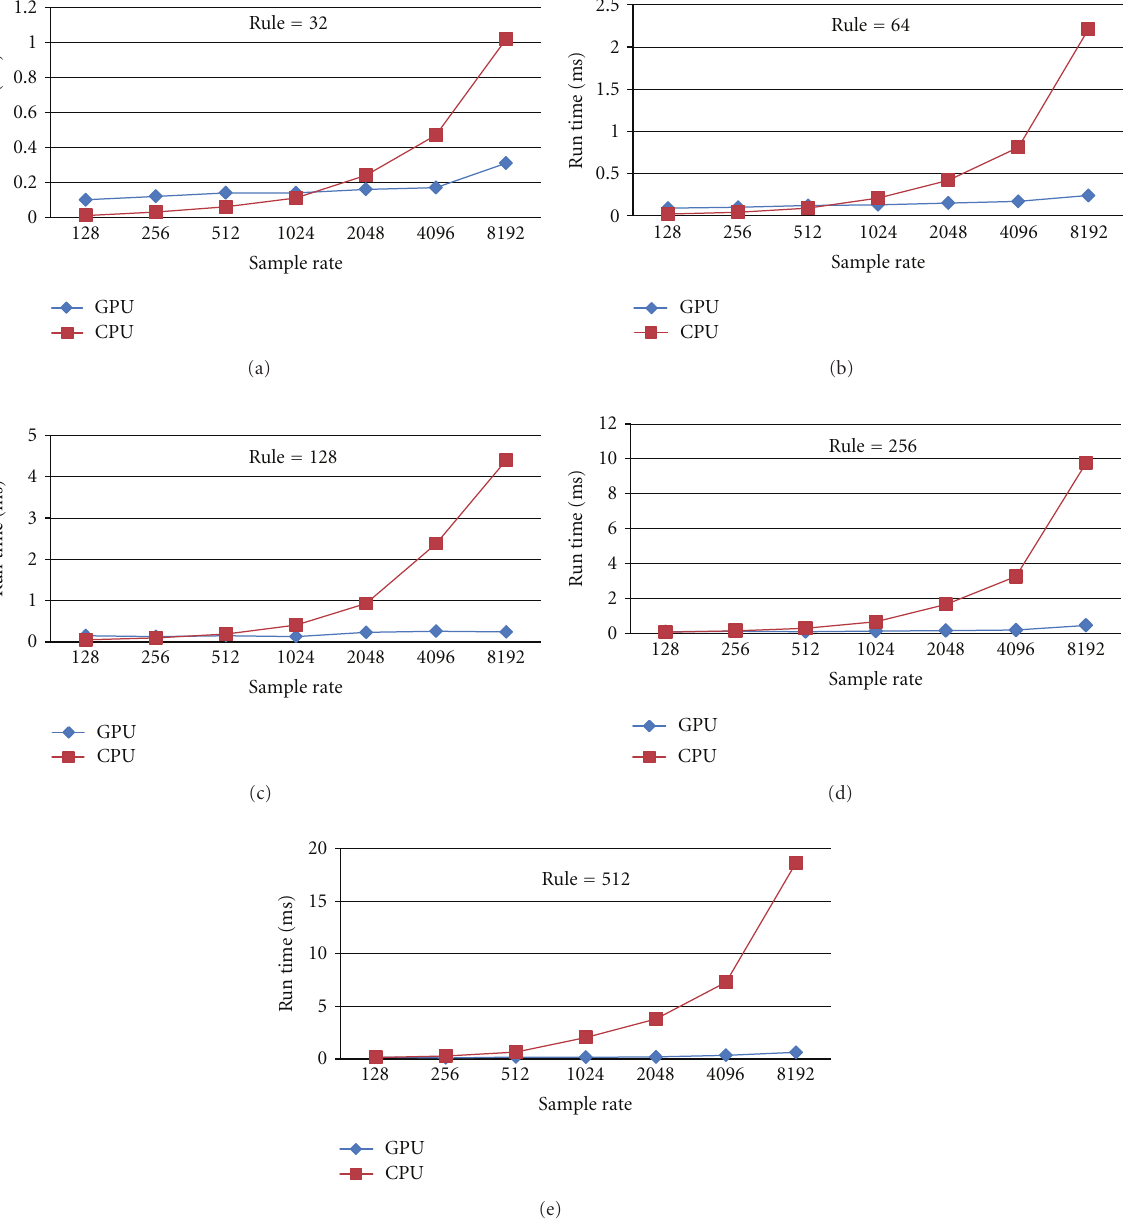
Figure 14: Run-time graph of the problem